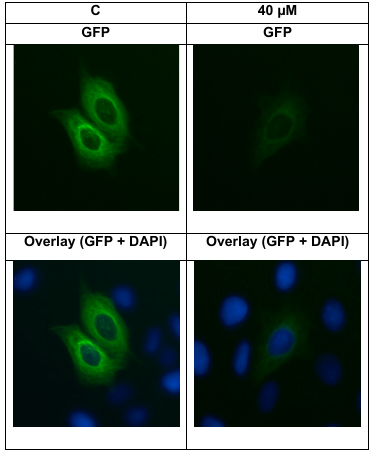
Figure 8. Secalonic acid F (SAF) altered the morphology of the microtubule network in U2OS cells. Panels show the micrographs of U2OS cells treated for 24 h at 40 µM of SAF.